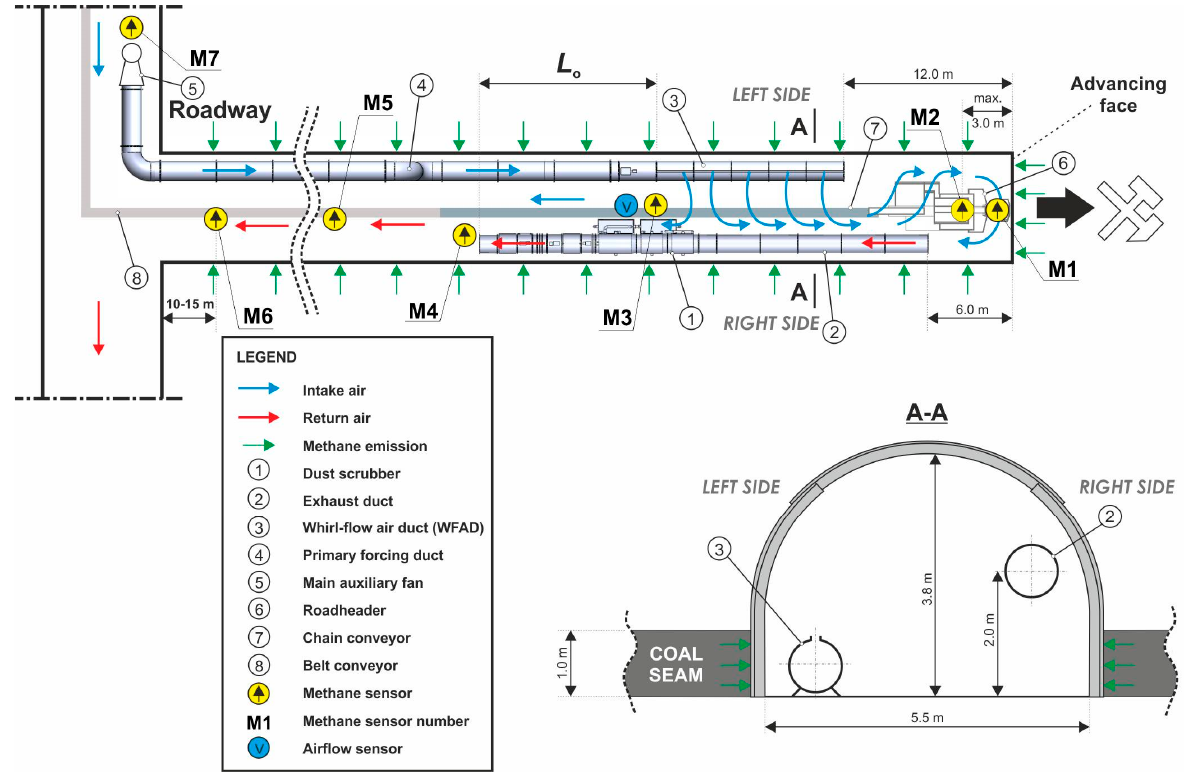
Figure 2. Scheme of equipment in the analyzed Belt Roadway.